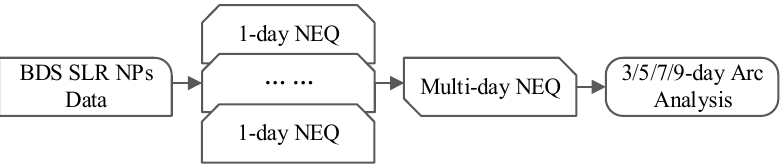
Figure 1. The multi-day arcs solution strategy.